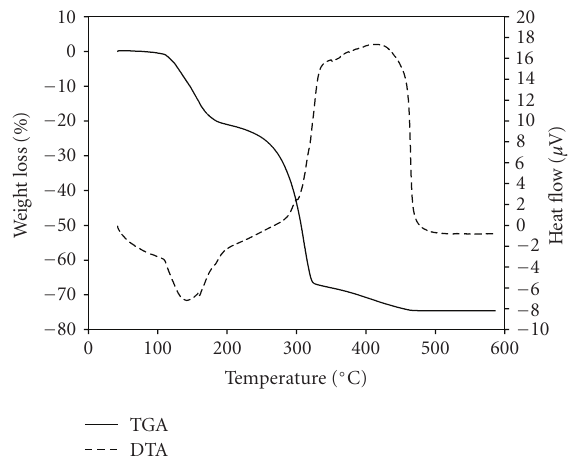
Figure 1: TG-DTA results for TiO 2 dry-gel where the TGA: full line and DTA: dashed line.